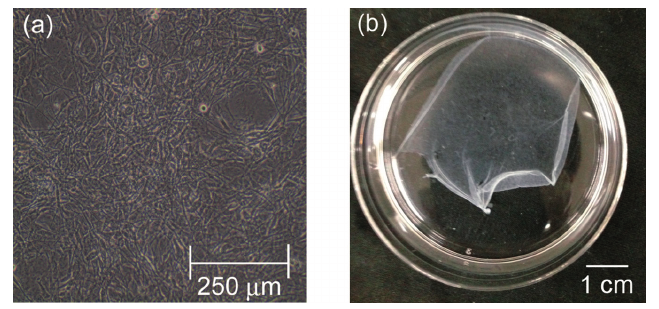
Figure 6. ( a ) Phase-contrast microscope image of NIH/3T3 cell on RGDS-ELP-layer at 37 °C. ( b ) Photograph of cell-sheet recovered from the confluent cell (as shown in Figure 6a) by cooling to 20